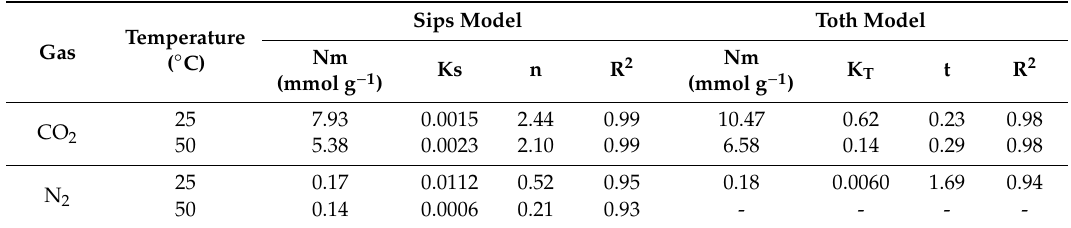
Table 6. The Sips and Toth parameters for CO 2 /N 2 isotherms at 25 and 50 °C. CN.RON2.